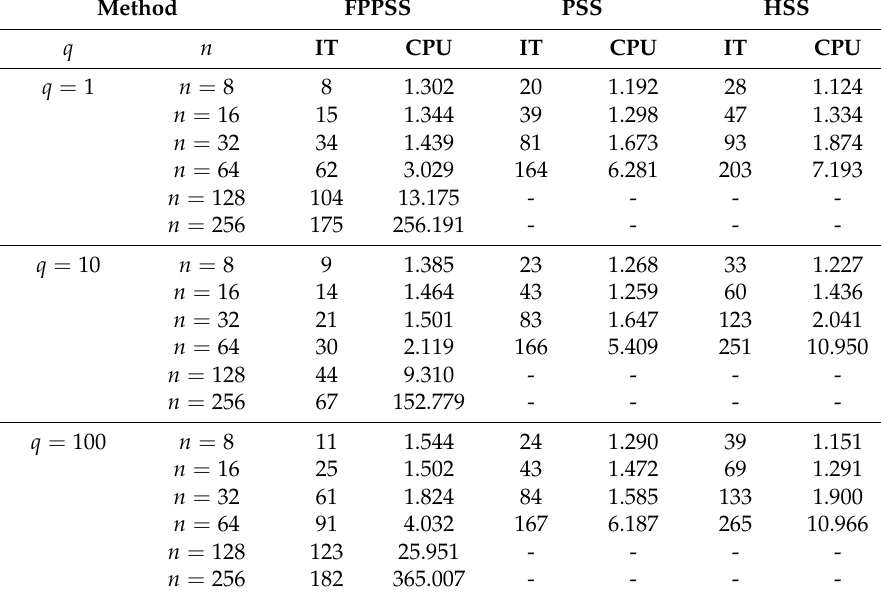
Table 5. IT and CPU for FPPSS, PSS, and HSS for Example 3 when using experimental quasi-optimal parameters.